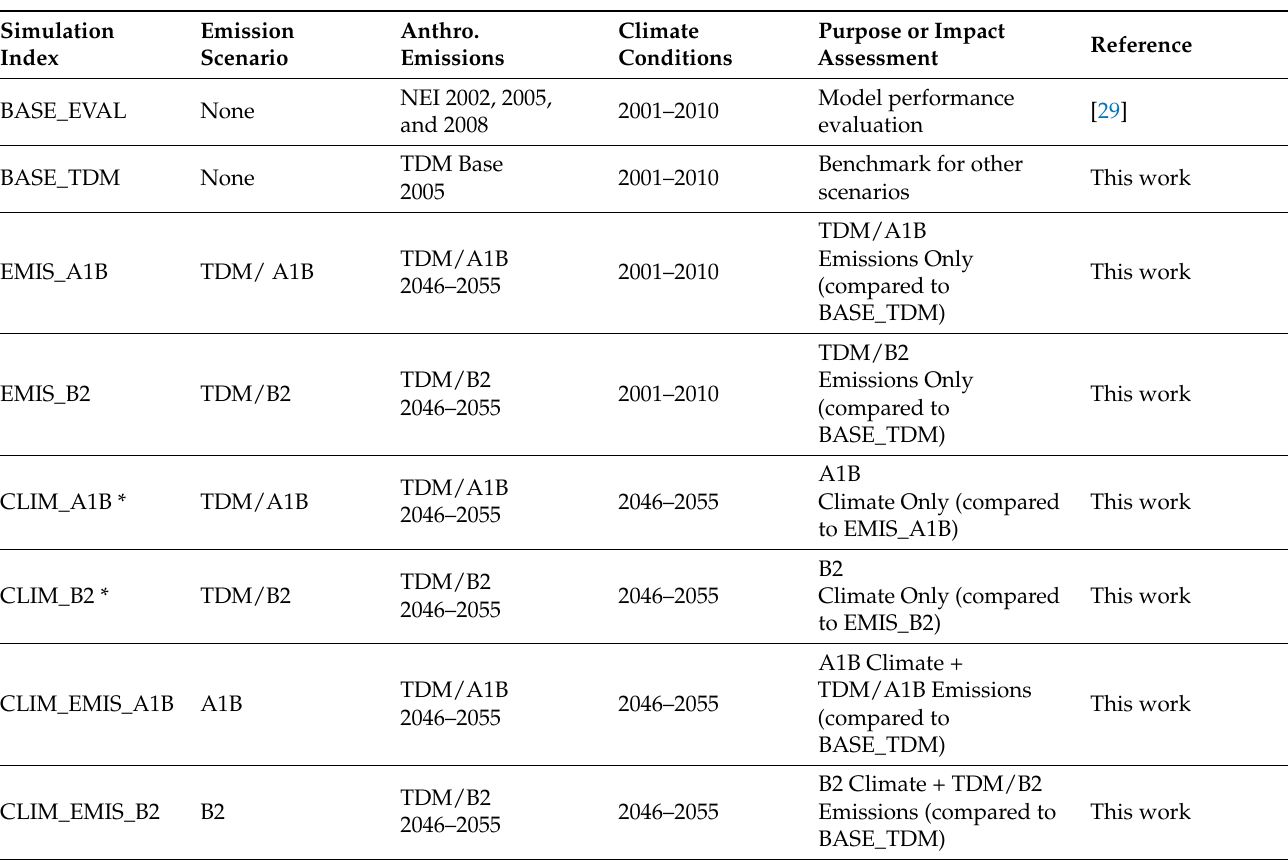
Table 1. Baseline simulations, additional TDM simulations, and derived results for impact assess- ments in this work.